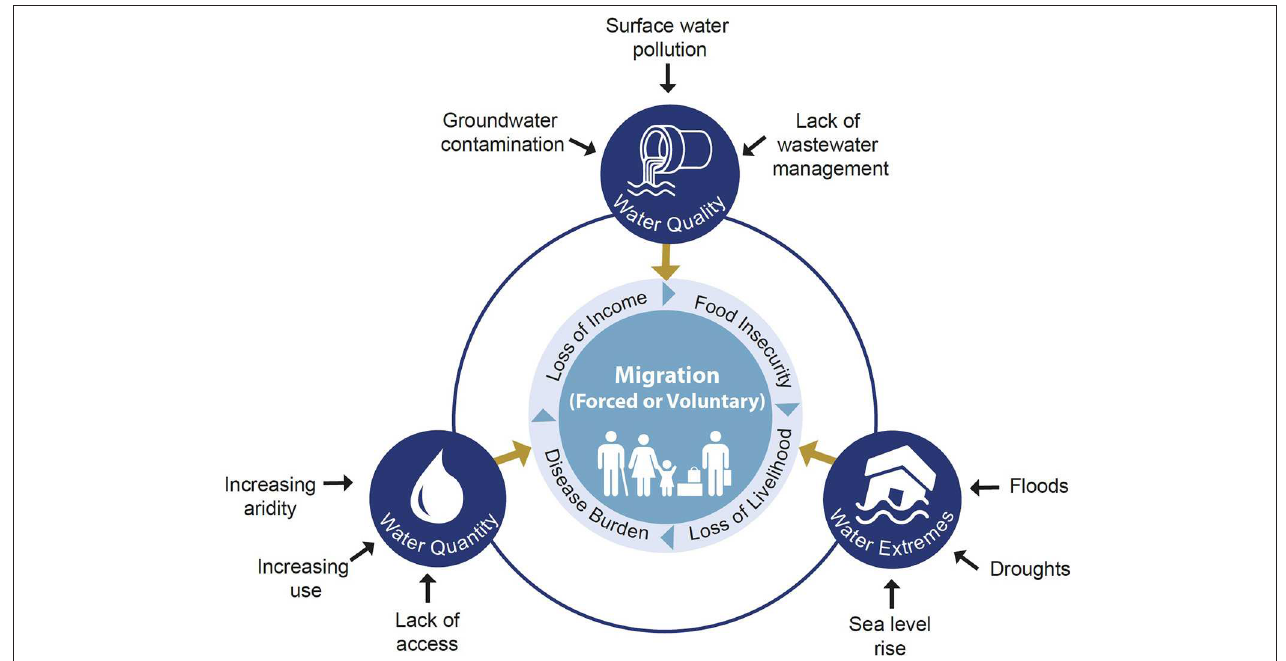
FIGURE 1 | Three-dimensional framework to assess the water-migration interconnections (Source: Nagabhatla et al.,